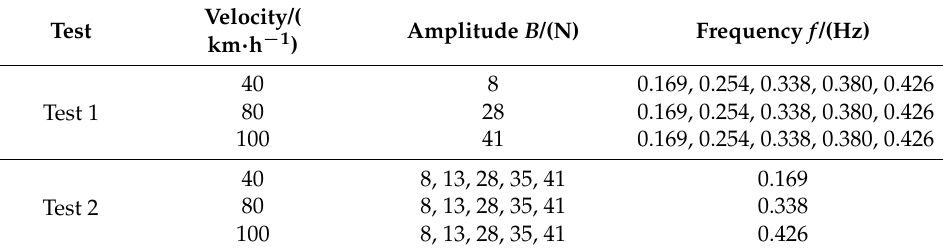
Table 4. Dynamic contact force parameters in decoupling experiments.